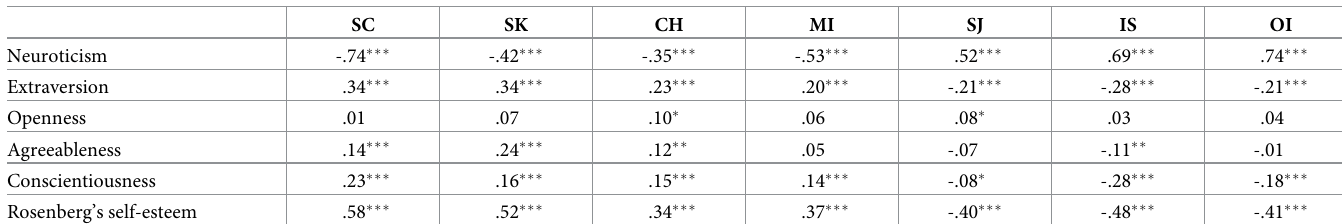
Table 7. Correlations between the SCS, the Big Five personality dimensions (NEO-FFI), and Self-Esteem (SES), measured using Pearson’s correlation coefficient. SC SK